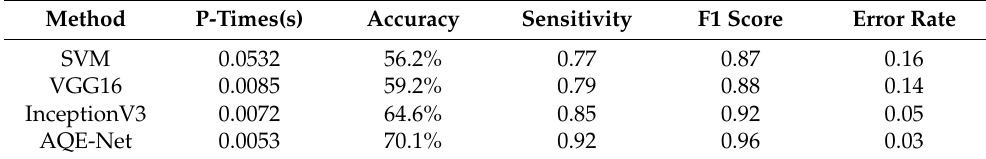
Table 3. Models’ performance on the KHI-AQI